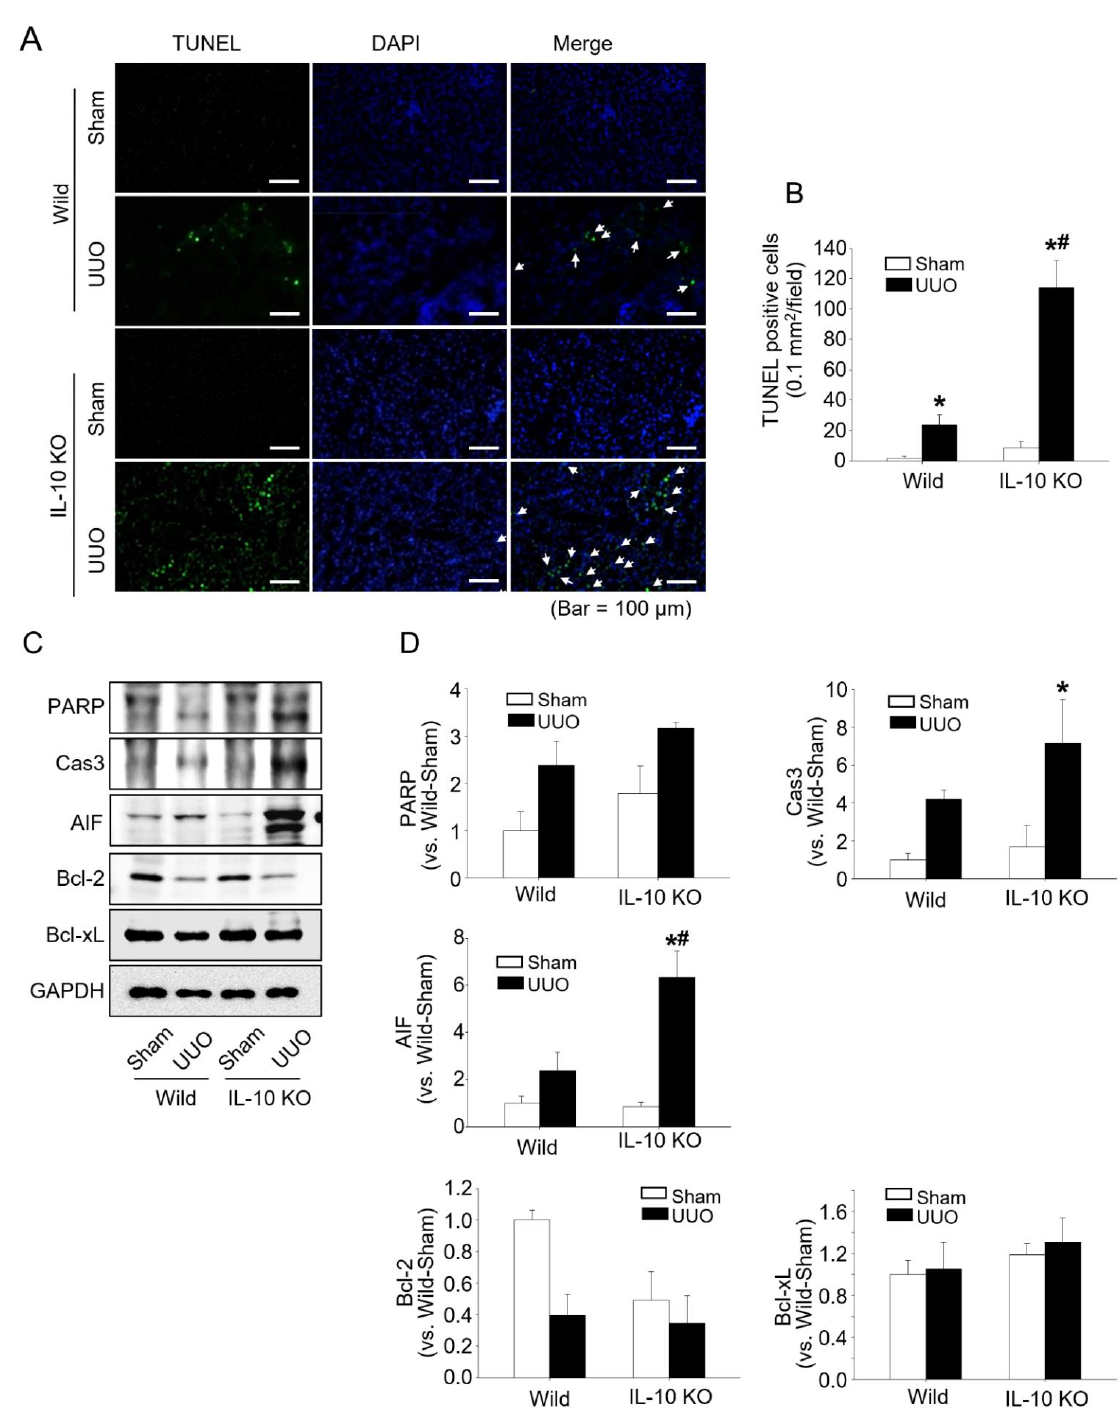
Figure 3. IL-10 deficiency aggravated apoptosis in the kidney 7 days after UUO. Apoptotic cells after UUO were detected by TUNEL staining (green and arrows pointed in merged figures) kidney tissues and were significantly more numerous in IL-10 − / − mice than in IL-10 +/+ . Nuclei were stained with DAPI (blue) ( A ). Histogram obtained by counting cells stained with TUNEL and DAPI ( B ). PARP, Cas3, AIF, Bcl-2, and Bcl-xL levels were determined with Western blotting. GAPDH was used as the loading control. Densities of bands were quantified using ImageJ software ( n = 3 to 4) and bars indicate means ± SEMs ( C , D ). * p < 0.05 vs. IL-10 +/+ -sham mice; # p < 0.05 vs. UUO induced IL-10 +/+